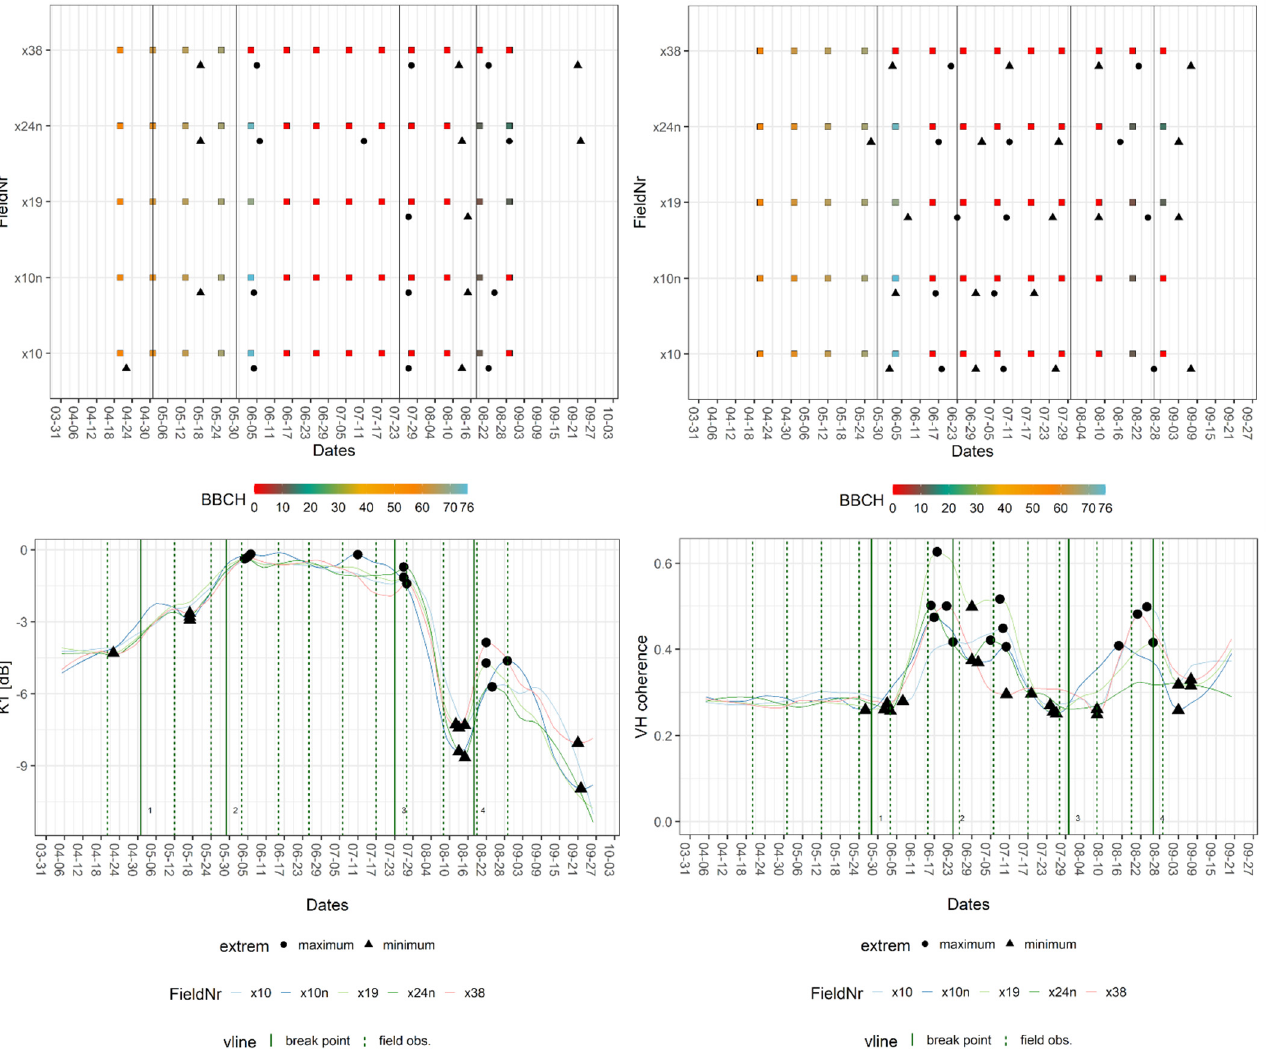
Figure 7. Exemplary breakpoint and extreme value analysis for K1 and VH coherence signatures of fields of canola. Upper part: BBCH progression of in situ measurements per field with dates of breakpoints (vertical line = breakpoint) and extrema (extreme). Lower part: crop signatures with breakpoints and extrema as well as dates of closest field observations (vertical line = field obs.). Table 6. Summary of relevant extrema and corresponding BBCH values for canola signatures. Phenological